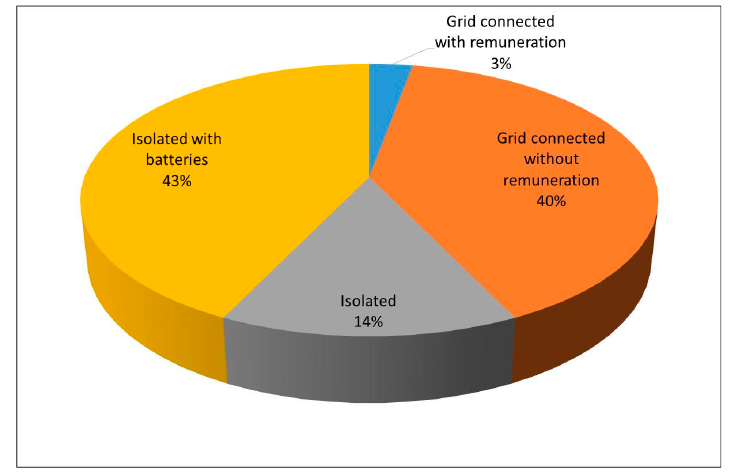
Figure 5. Type of installation.